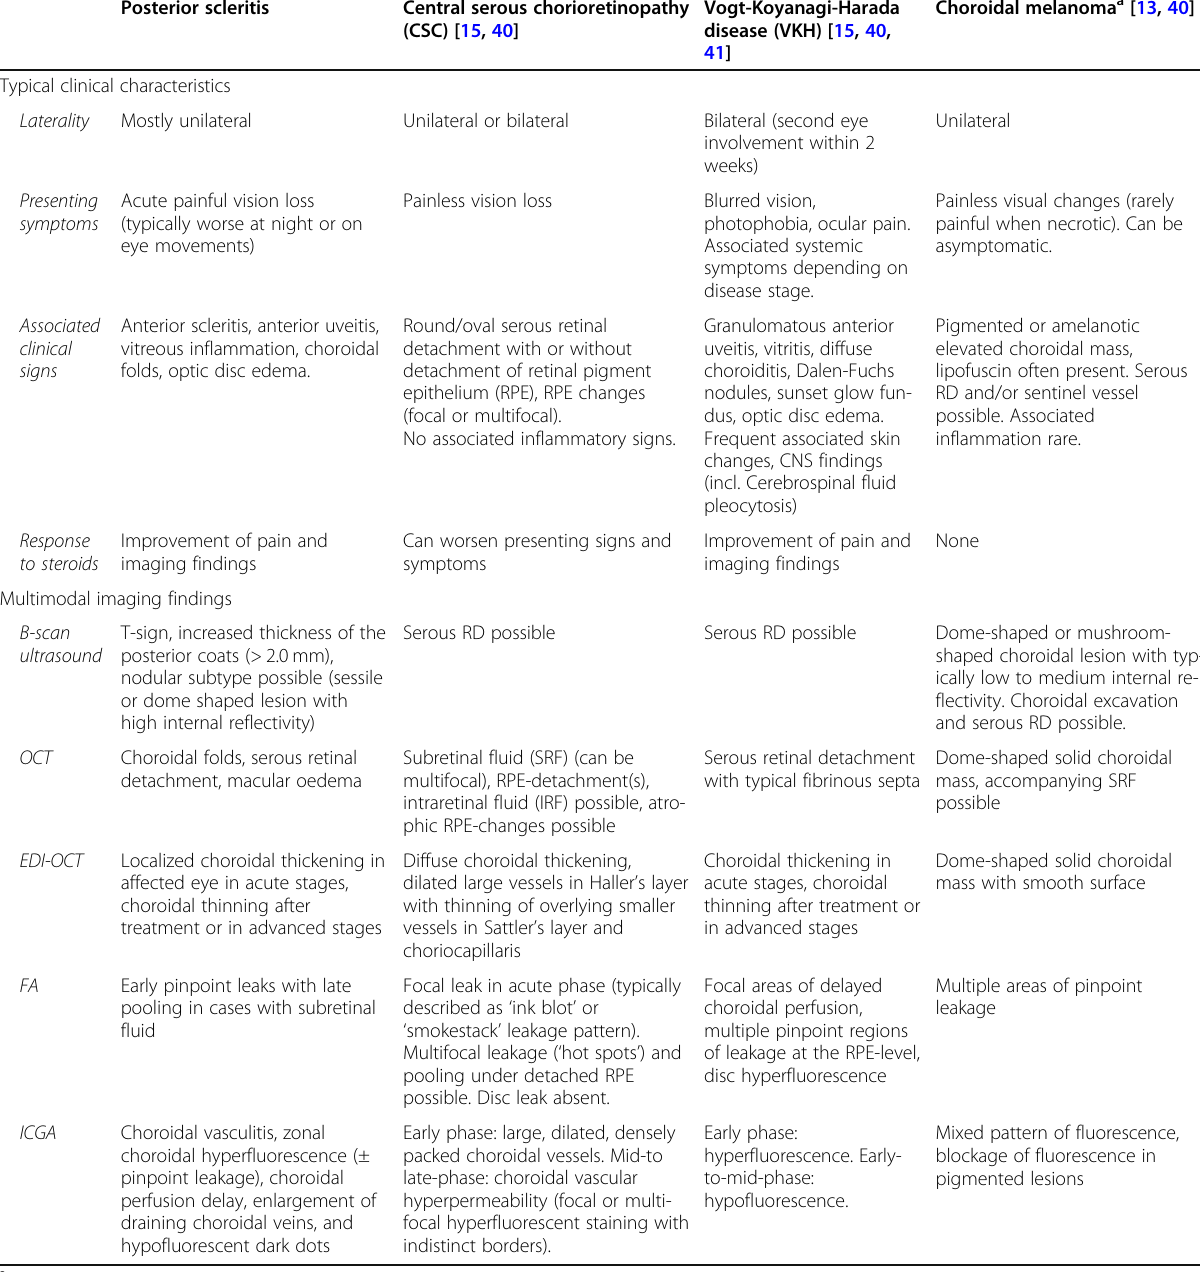
Table 2 Differential diagnosis of posterior scleritis Posterior scleritis Central serous chorioretinopathy (CSC) [15,